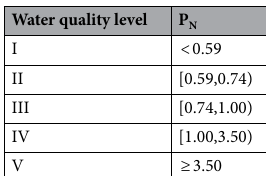
Table 2. Water quality level determination based on the Nemerow pollution index